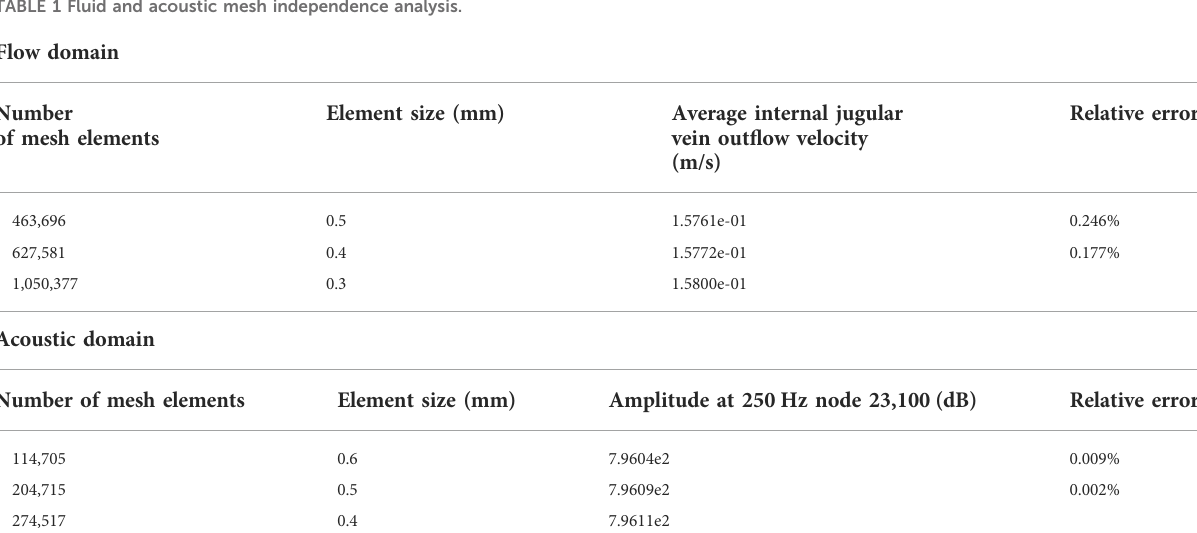
TABLE 1 Fluid and acoustic mesh independence